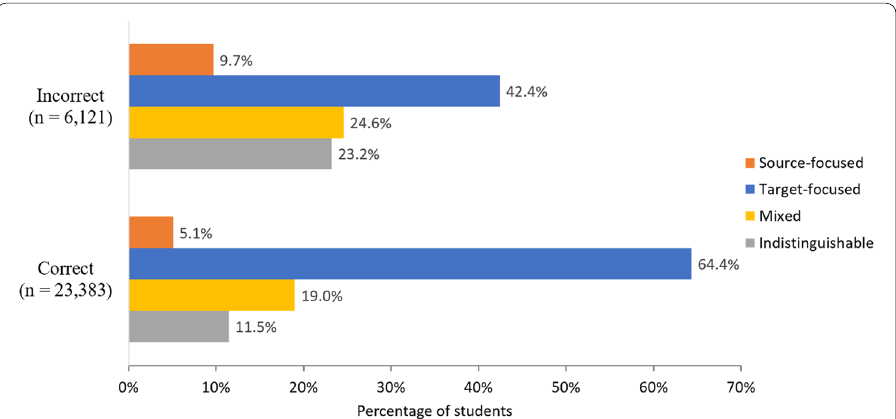
Fig. 6 Percentage of eighth‑grade students with a correct and incorrect response who applied a source‑focused, target‑focused, indistinguishable, or mixed strategy in responding to the